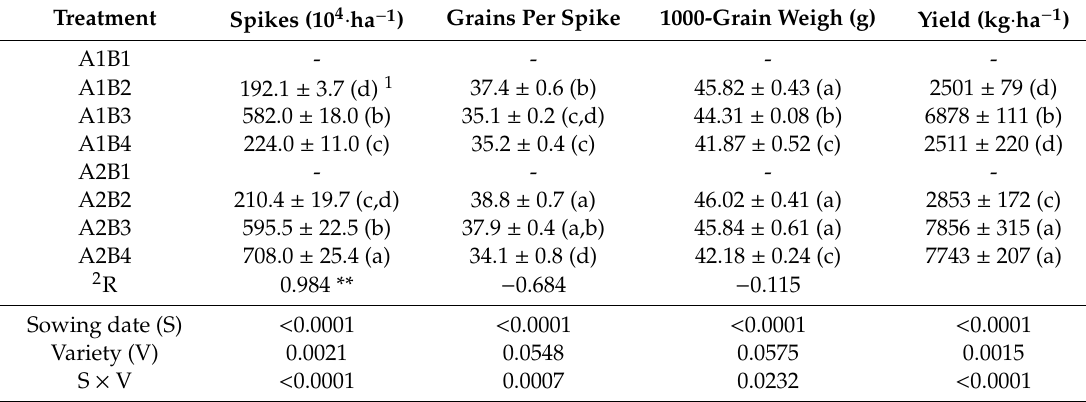
Table 9. Wheat yield and yield component for di ff erent sowing dates (2013–2014).